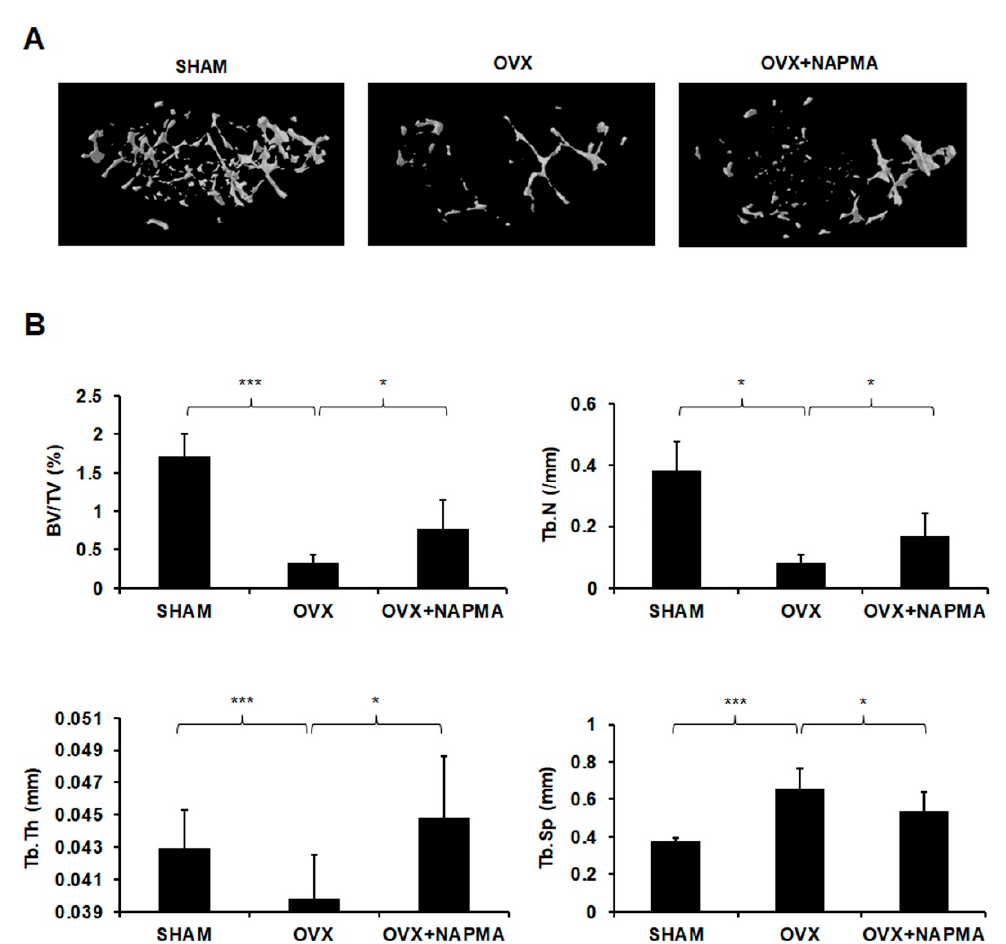
Figure 5. NAPMA inhibits OVX-induced bone loss. ( A ) OVX mice were euthanized after six weeks of NAPMA treatment. Micro-CT images of the distal femurs from the sham-operated group (SHAM), OVX group, and OVX + NAPMA group (NAPMA 10 mg / kg / each day) were obtained. ( B ) Quantitative analyses of BV / TV, Tb.N, Tb.Th, and Tb.Sp (N = 6 per group). * p < 0.05; *** p <